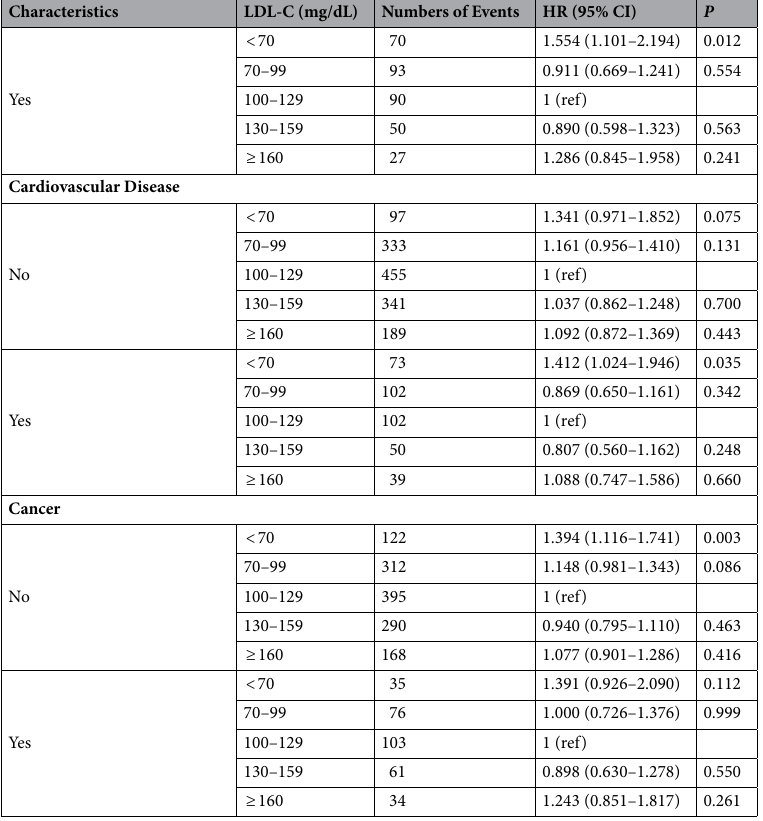
Table 3. Stratified analysis of the relationship between LDL-C level and all-cause mortality in the NHANES Study, 1999–2014. Adjusted for age (continuous), sex, race, marital status, education level, smoking status, BMI (continuous), hypertension, diabetes, cardiovascular disease, cancer. CIs Confidence intervals, HR hazard ratio, LDL-C low-density lipoprotein